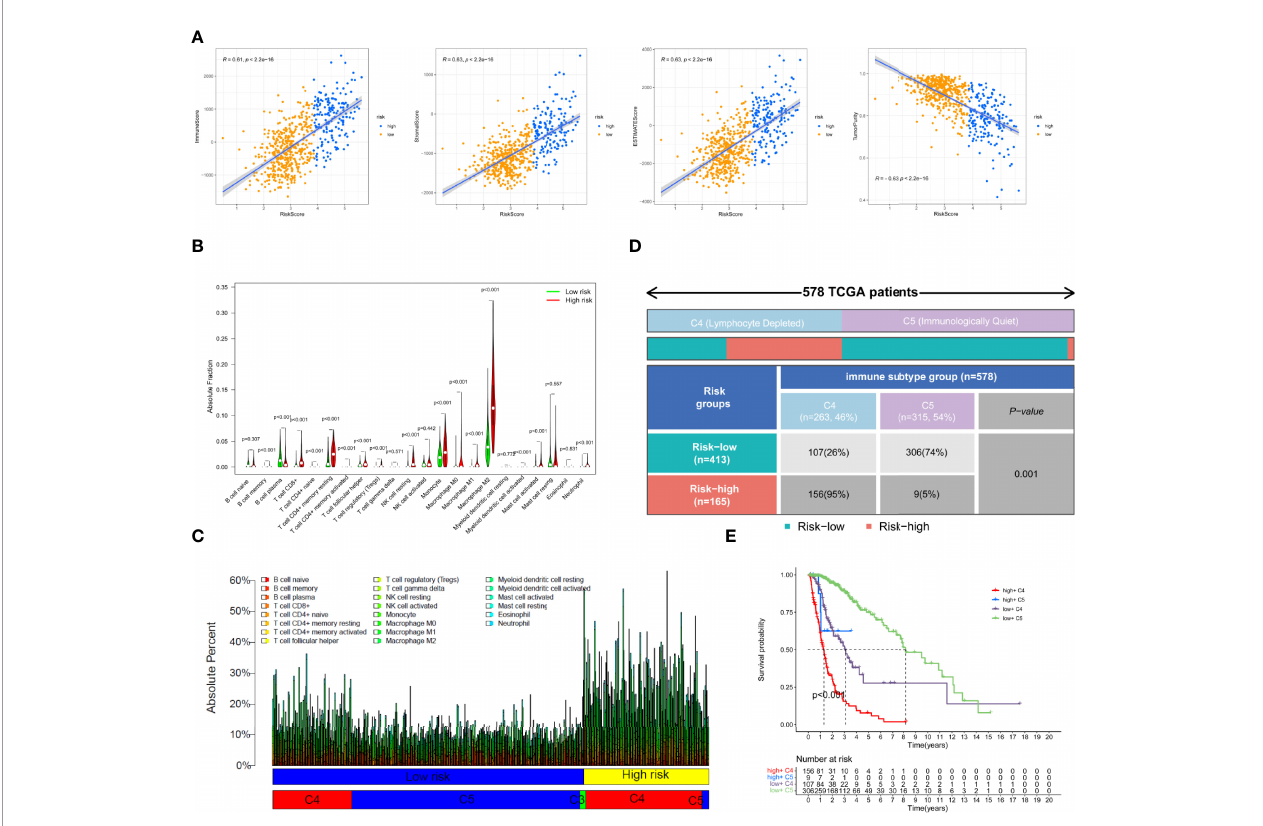
FIGURE 5 | Tumor microenvironment and immune cell in fi ltration analysis in the TCGA cohort. (A) The correlation of immune scores, stromal scores, ESTIMATE scores, and tumor purity with risk scores. (B) Comparison of the degree of in fi ltration of 22 immune cells in the different risk groups. (C) The absolute fraction of immune cells between different subgroups in the TCGA glioma patients. (D) Heatmap and table showing the distribution of immune subtype between the two risk groups in the TCGA cohort. (E) Comparison of the survival difference between groupings after combining risk signature and immune subtypes by Kaplan – Meier survival